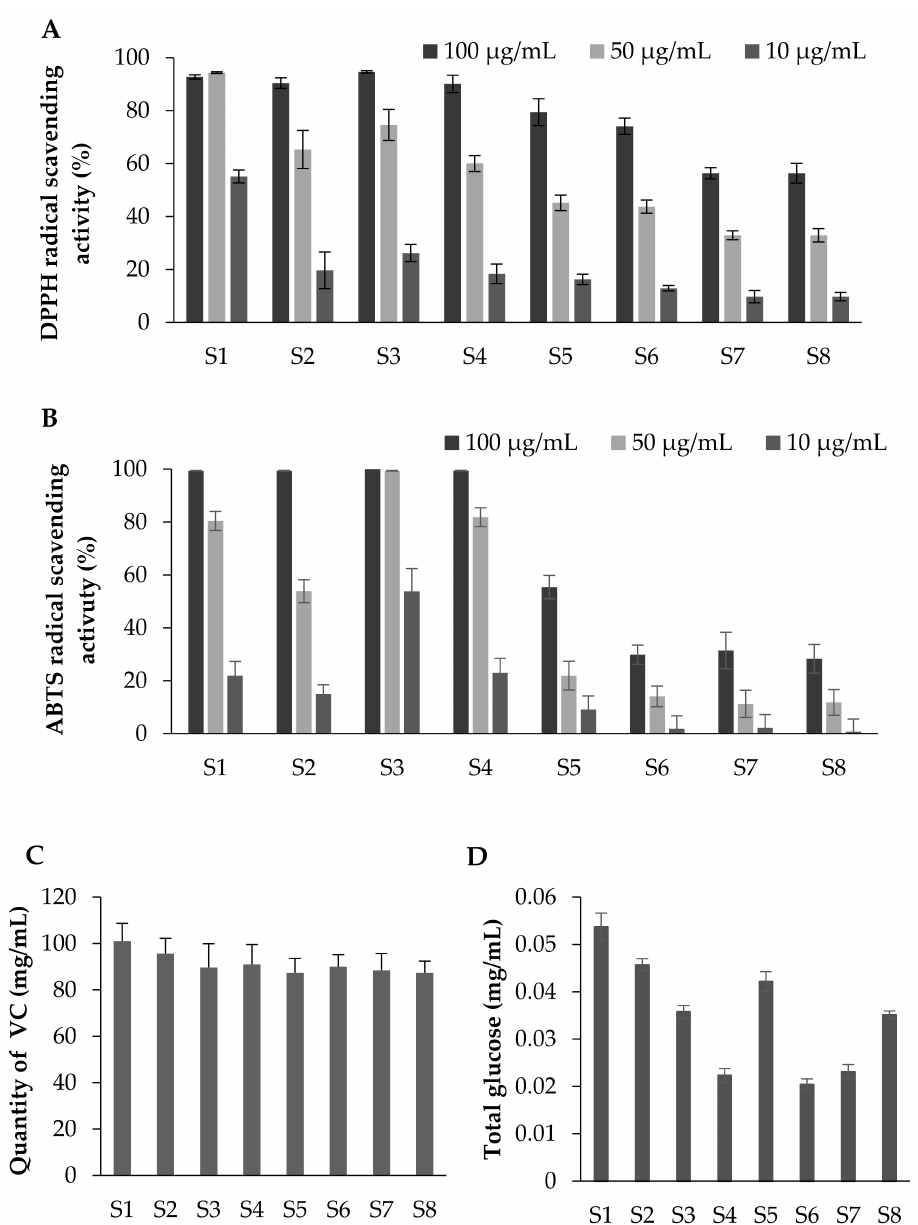
Figure 4. DPPH radical scavenging activity and ABTS radical scavenging activity at each ripening stage. ( A ) DPPH radical scavenging activity. Vitamin E was used as a control. Error bars represent the SD of the mean ( n = 8). ( B ) ABTS radical scavenging activity. (+)-Catechin was used as a control. Error bars represent the SD of the mean ( n = 8). ( C ) The vitamin C content was quantified using the 2,4-dinitrophenylhydrazine method. Data represent 1 mg of ascorbic acid equivalents per 100 mg/mL of the raspberry fruit extract DMSO solution. Error bars represent the SD of the mean ( n = 4). ( D ) The total glucose content was determined using the phenol-sulfuric acid method. Data represent 1 mg of glucose equivalents per 100 mg/mL of the raspberry fruit extract DMSO solution. Error bars represent the SD of the mean ( n =